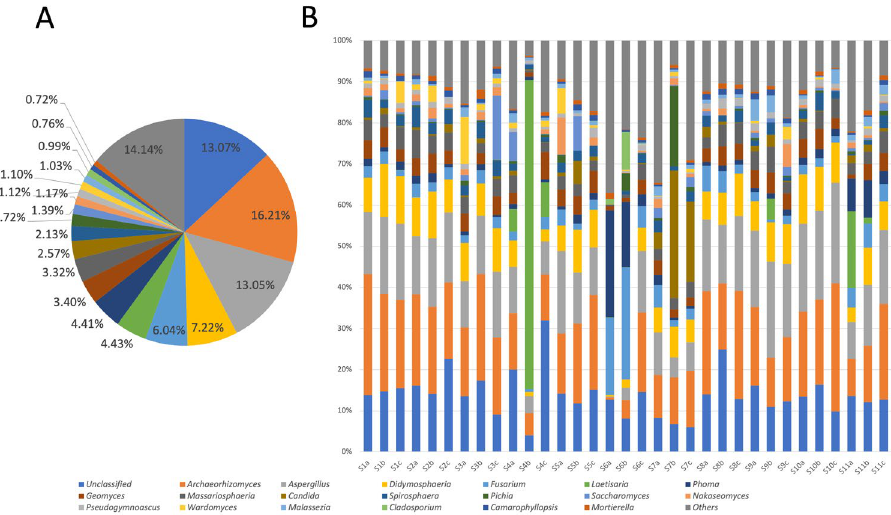
Figure 2. The ( A ) fungal composition and ( B ) genus distribution of 33 samples from 11 coastal locations (S1–S11) in Guangdong, South China. Three replicates (e.g., S1a, S1b, S1c) were collected from each site.